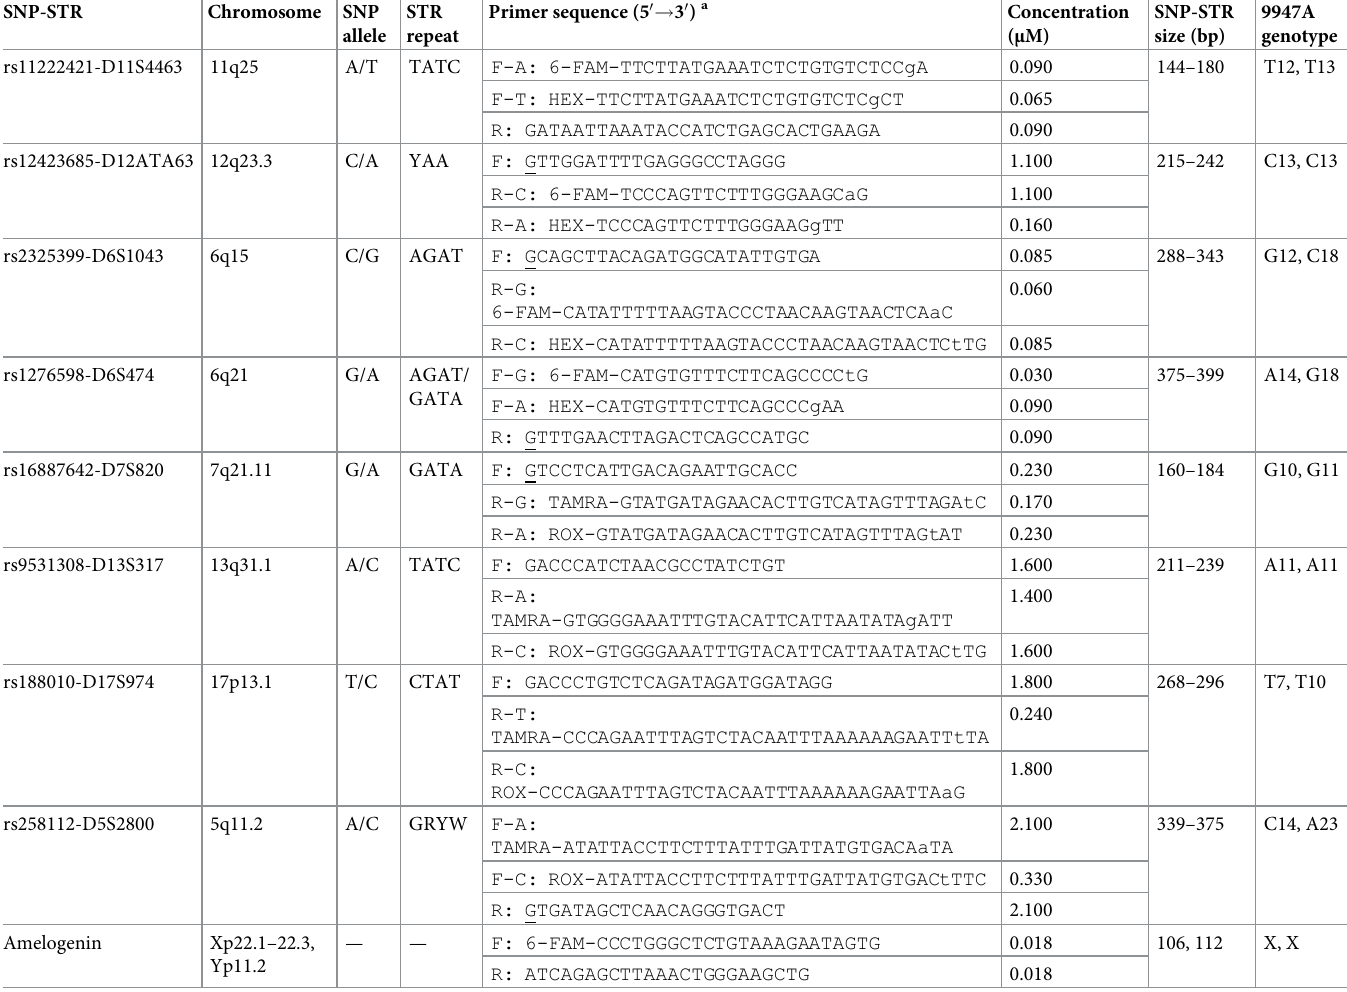
Table 1. Marker information, primer sequences and concentrations used in the SNP-STR multiplex assay in this study. SNP-STR Chromosome SNP STR allele